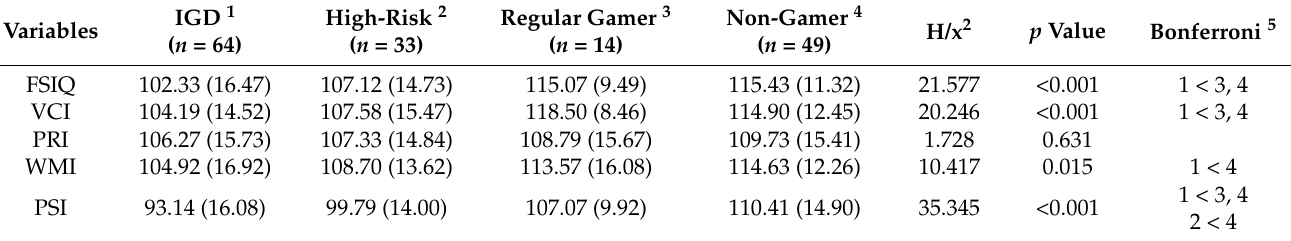
Table 4. Comparison of intelligence level among four groups ( n = 160).